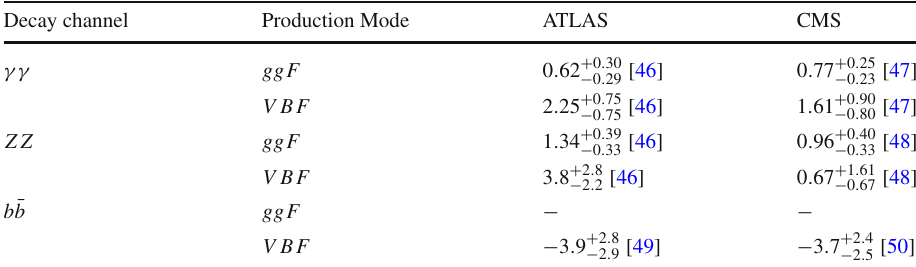
Table 2 The Higgs signal strengths in various production and decay channels measured by ATLAS and CMS at LHC Run 2 √ s = 13 (